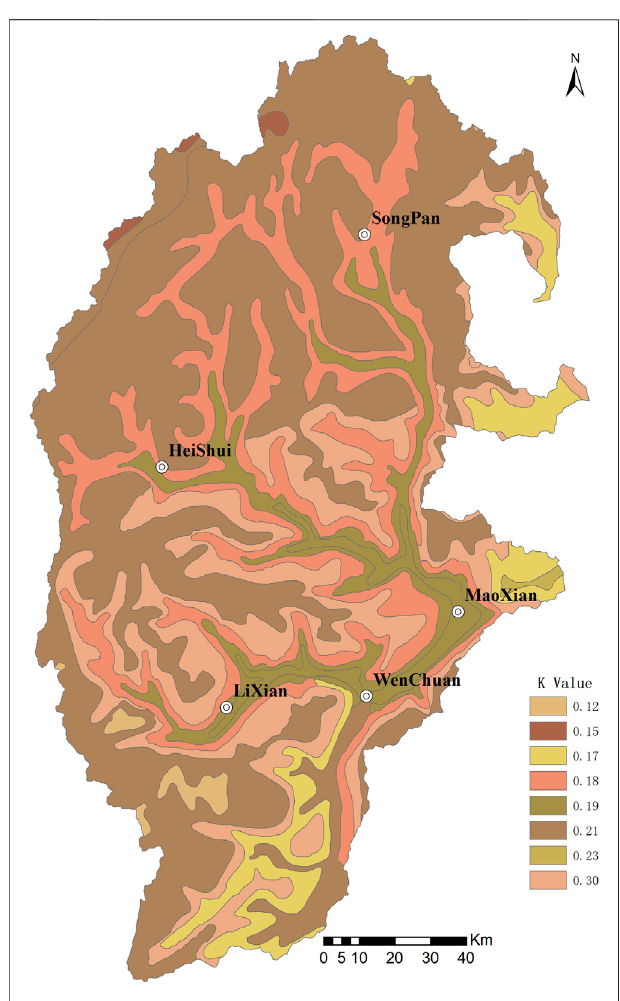
FIGURE 4 | K value of soil erodible factor in the upper reaches of the Minjiang